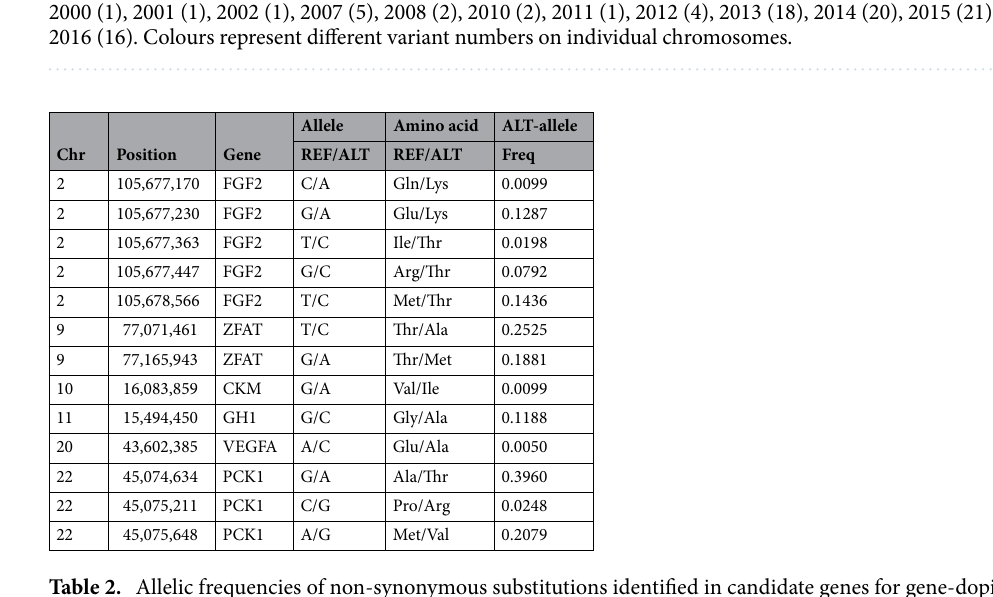
Table 2. Allelic frequencies of non-synonymous substitutions identified in candidate genes for gene-doping control. Chr chromosome, REF reference, ALT alternative, Freq